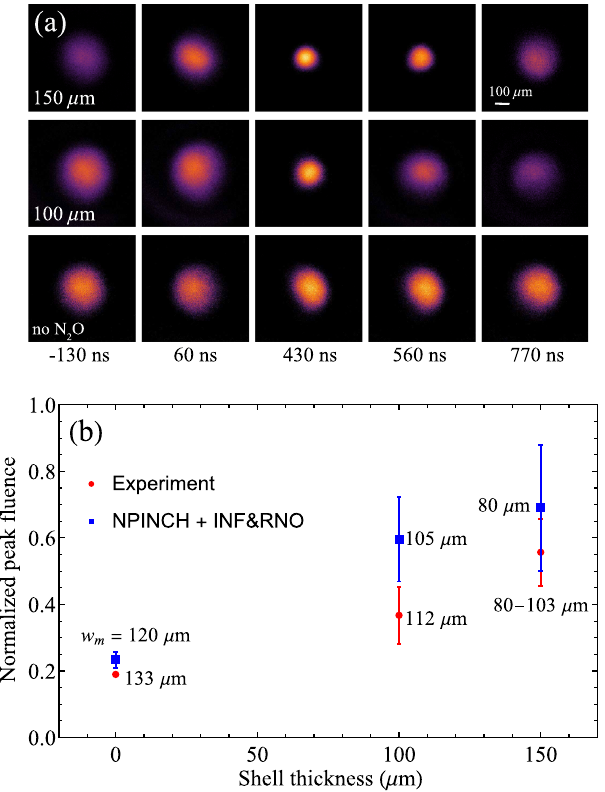
FIG. 4. (a) Representative images of the laser output mode at the exit of the capillary for 150, 100, and 0 μ m shell thicknesses for discharge delays of − 130, 60, 430, 560, and 770 ns. Image intensities have been normalized to the maximum intensity for that diameter. (b) Output fluence measured in the experiment (red) and simulated using the experimentally measured matched spot size (blue) as a function of shell thickness. Data were averaged for delays between 20 ns before and 60 ns after the peak of the discharge pulse. The error bars correspond to the standard deviation of the data, and the labels represent the matched spot sizes w m . In the case of no solid N 2 O, the experimental normalized peak fluence has an error of